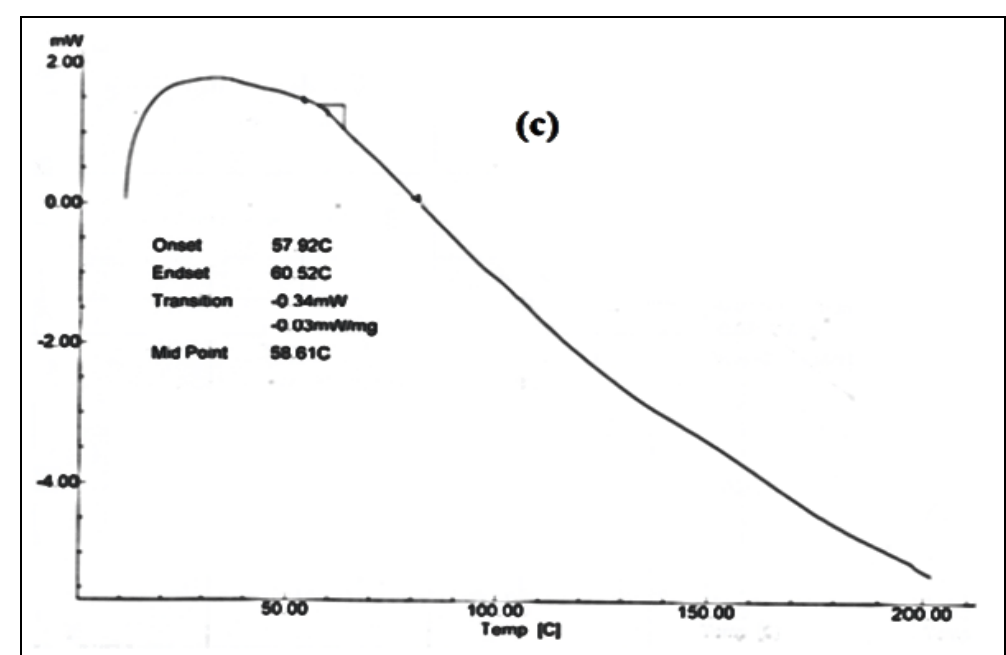
Fig.20: (Temperature glass transition) curves for UP/ nano SiO